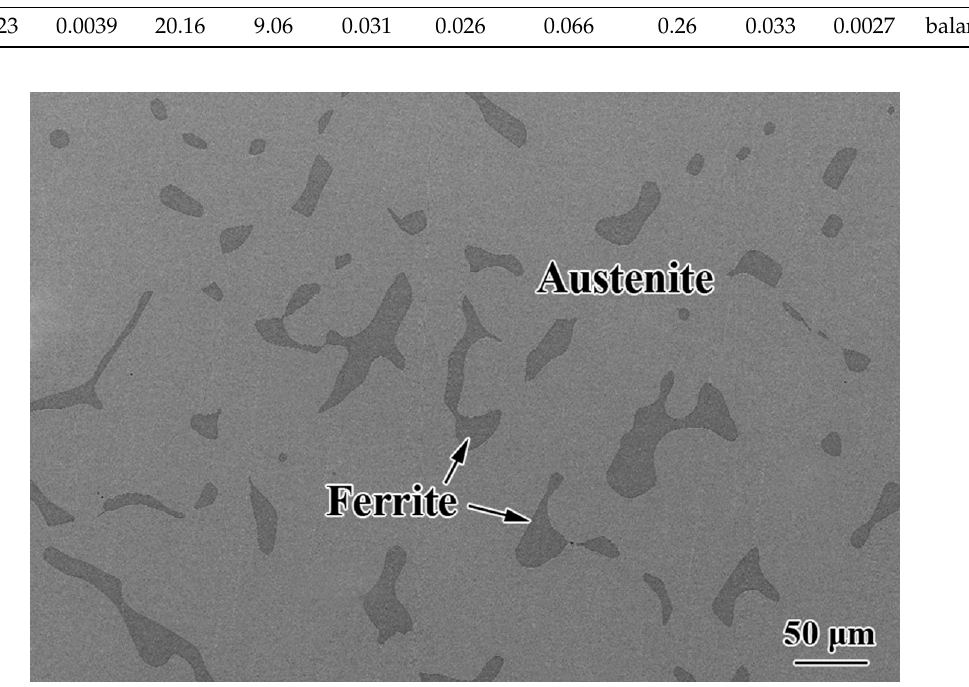
Figure 1. SEM microstructure of as-received Z3CN20.09M cast austenite stainless steel.